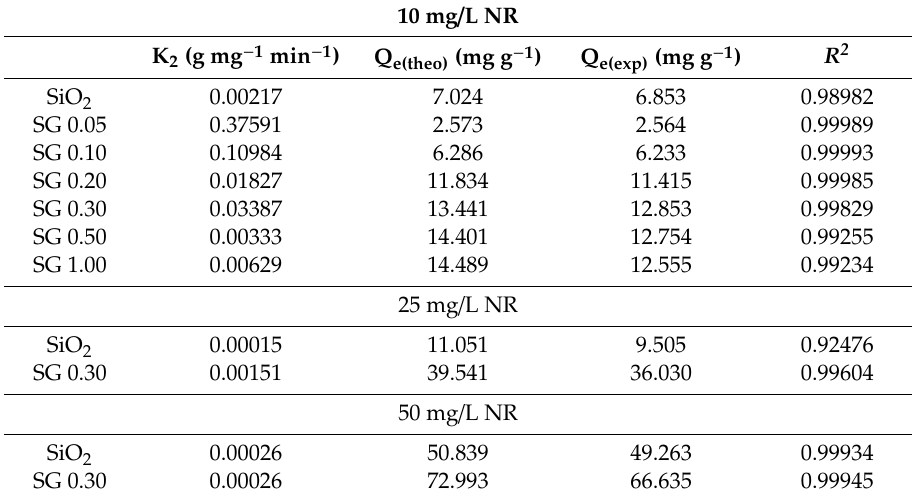
Table 2. Pseudo-second-order kinetic parameters for the adsorption of neutral red at various initial